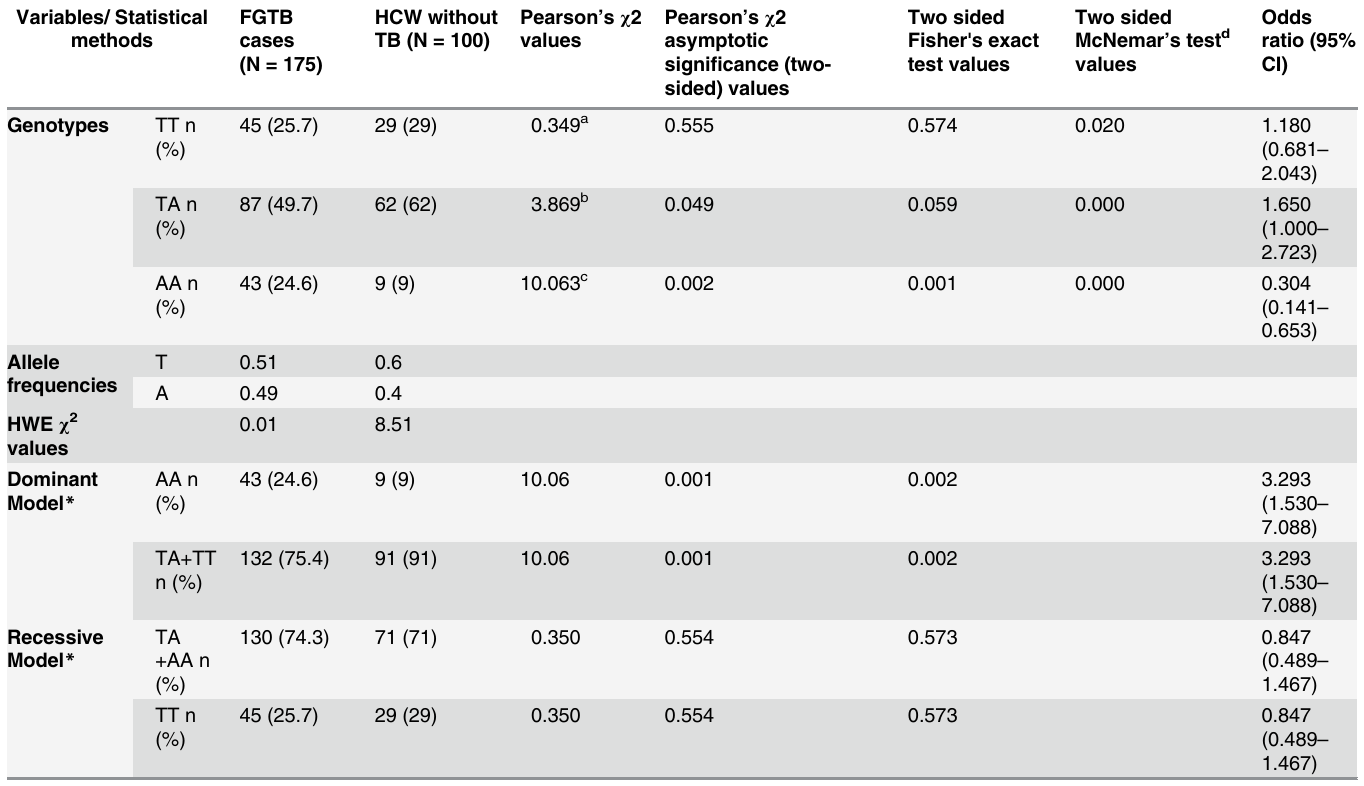
Table 8. The genotype distribution of the IFN- γ (+874T/A) gene polymorphism among infertile women with FGTB and HCW without TB. Variables/ Statistical